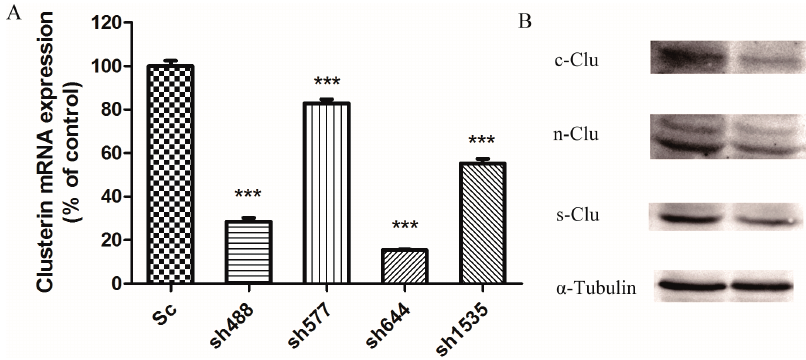
Figure 1. Knockdown of Clu expression in N2a cells by RNA